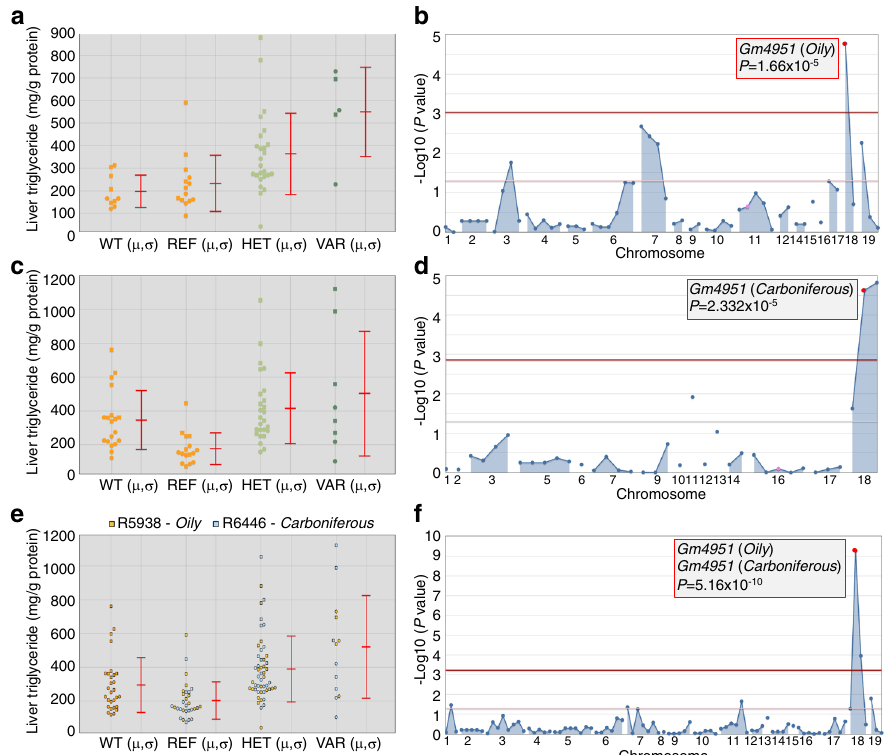
Fig. 1 Identi fi cation and mapping of Oily and Carboniferous . a Liver triglyceride data from G3 mice plotted vs. genotype at the Oily mutation site of Gm4951 after four weeks on a HFD ( n = 10 mice in WT; n = 14 mice in REF; n = 25 mice in HET; n = 5 mice in VAR). b Manhattan plot showing P values calculated using a likehood-ratio test from an additive model of inheritance. c Liver triglyceride data from G3 mice plotted vs. genotype at the Carboniferous mutation site of Gm4951 after four weeks on a HFD ( n = 19 mice in WT; n = 16 mice in REF; n = 26 mice in HET; n = 8 mice in VAR). d Manhattan plot showing P values calculated using a likehood-ratio test from an additive model of inheritance. e , f Liver triglyceride data from pedigrees R5938 ( Oily ) and R6446 ( Carboniferous ) were pooled together in superpedigree analysis and plotted as in a and c ( n = 29 mice in WT; n = 30 mice in REF; n = 51 mice in HET; n = 13 mice in VAR); Manhattan plot as in ( b ) and ( d ). P values were calculated using a likehood-ratio test from an additive model of inheritance. WT, C57BL/6J mice age-matched with G3 mice; REF, G3 mice homozygous for the reference allele of the indicated gene; HET, G3 mice heterozygous for the reference allele and for the mutant allele; VAR, G3 mice homozygous for the mutant allele. Each data point represents one mouse; mean ( μ ) and SD ( σ ) are indicated ( a , c , e ). Data are from one and Gm4951 − / − mice (Fig. 3k – o). Histologically, compared to (Supplementary Fig. 3f) and FFA (Supplementary Fig. 3g) in the liver, with no change in liver cholesterol (Supplementary Fig. 3h).